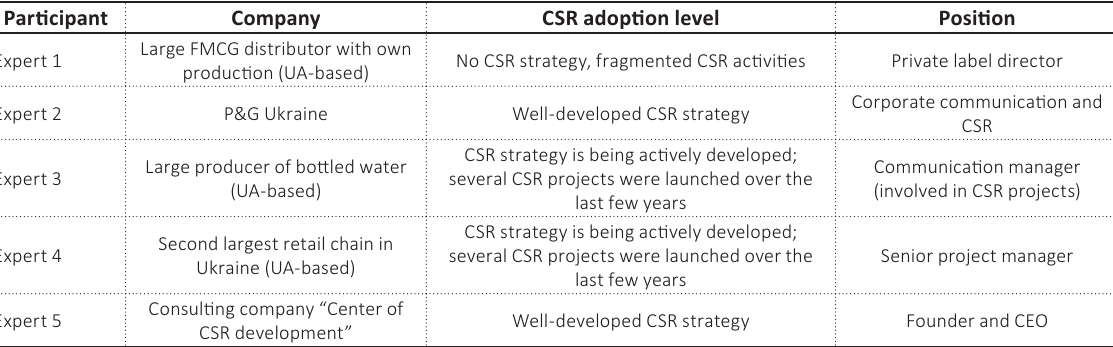
Table A1. Overview of experts participated in the interviews